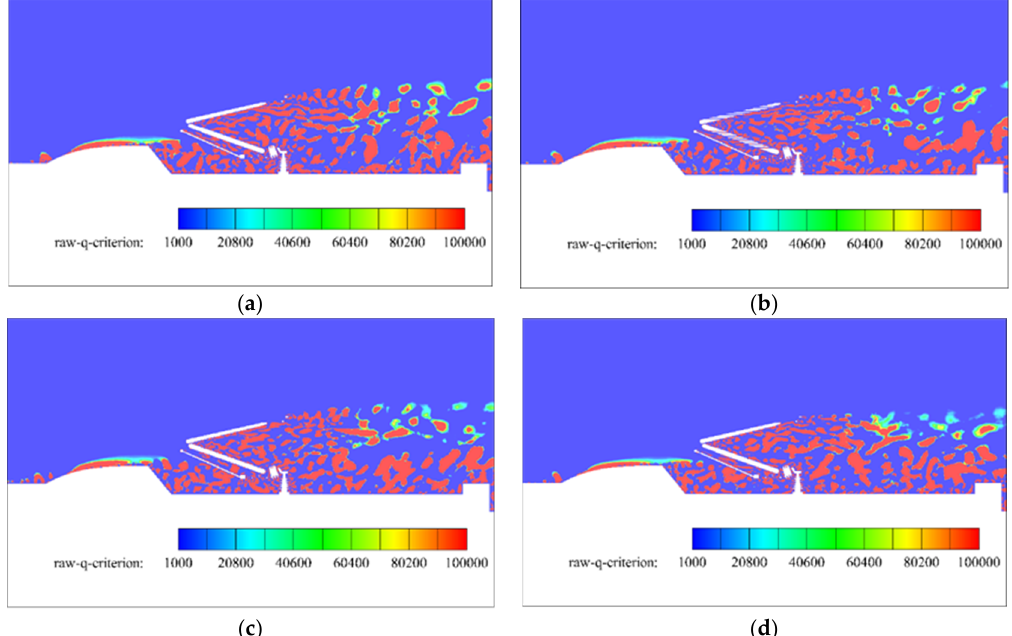
Figure 6. Q-value distribution on the longitudinal symmetry surface. ( a ) Original model. ( b ) Opened model. ( c ) Slotted model. ( d ) Airfoil model.